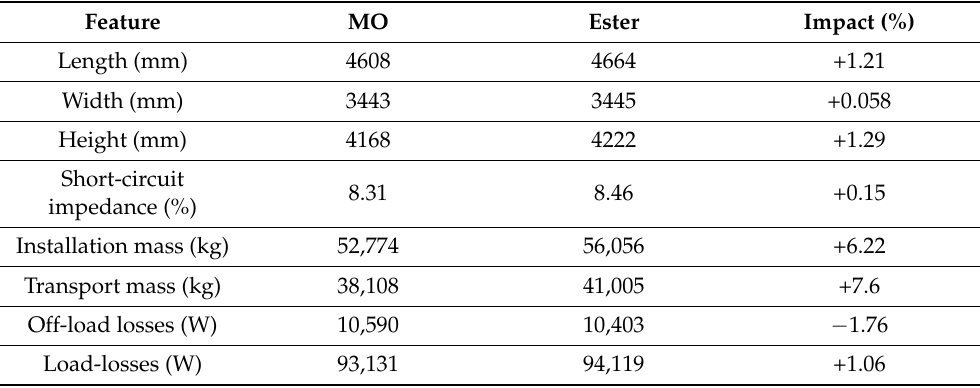
Table 3. Case 1—transformers’ final